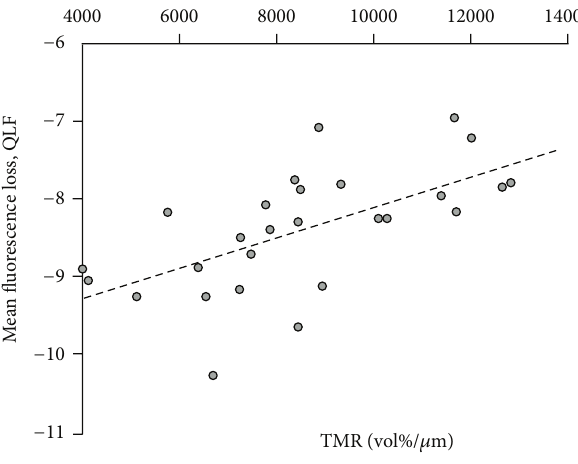
Figure 4: Correlation between QLF and